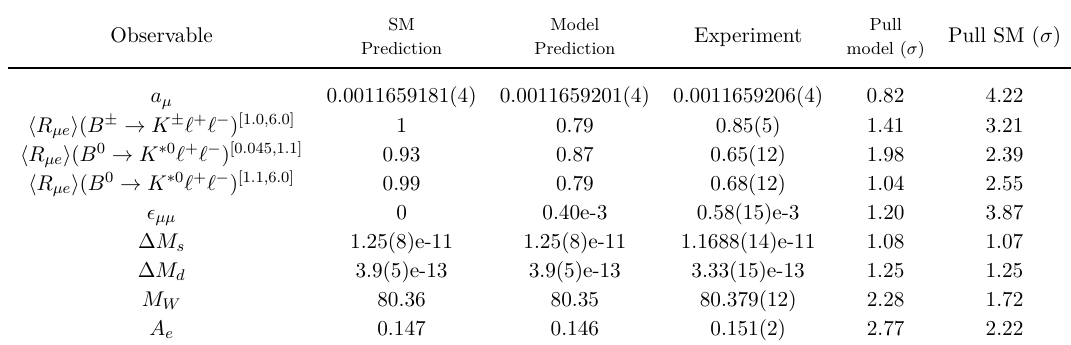
Table 4 . Individual values for the SM prediction, model prediction, experimental measure and pulls of the most relevant observables as given by smelli . Definitions of these observables (and updated values) can be read from the flavio [88] documentation, which smelli uses to calculate contributions from the Wilson coefficients to low-energy